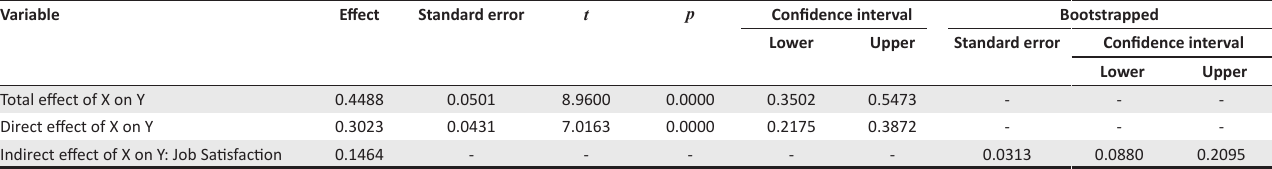
Work-life balance conflict level FIGURE 5: Engagement as a moderator on the work-life balance–turnover intentions relationship (two-way interaction). TABLE 4: Mediation results – total and indirect effects of Hypothesis 2. Variable